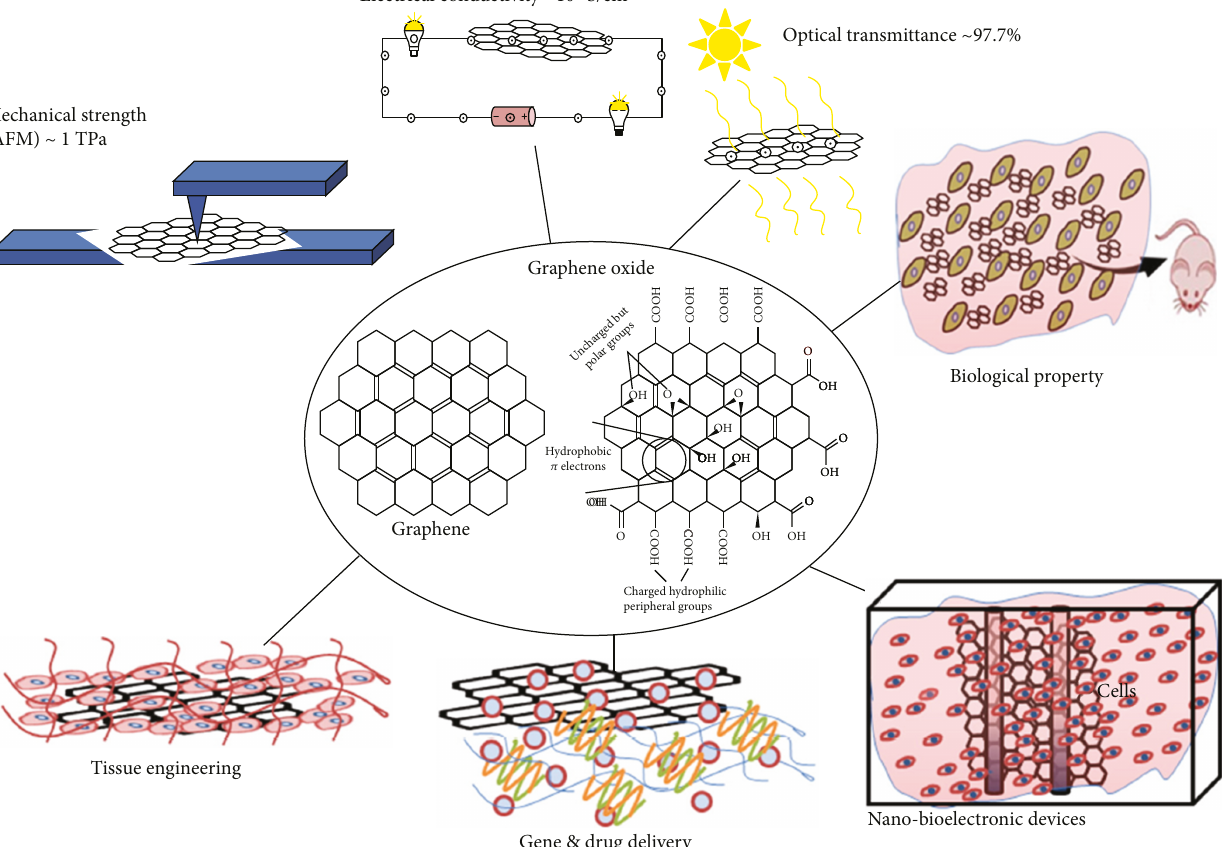
Figure 1: Schematic overview of various applications of graphene. Graphene-based nanomaterials have been explored for various nonmedical and biomedical applications due to their excellent mechanical, electrical, and optical properties